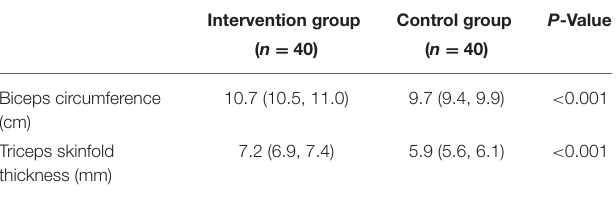
TABLE 3 | Anthropometry at discharge. Intervention group